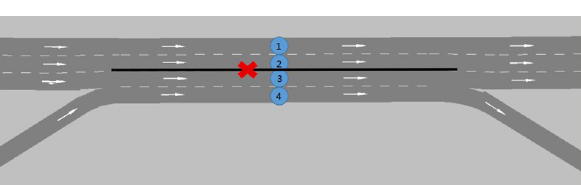
Figure 11 Lane-changing isolation scheme for weaving area (Scenario